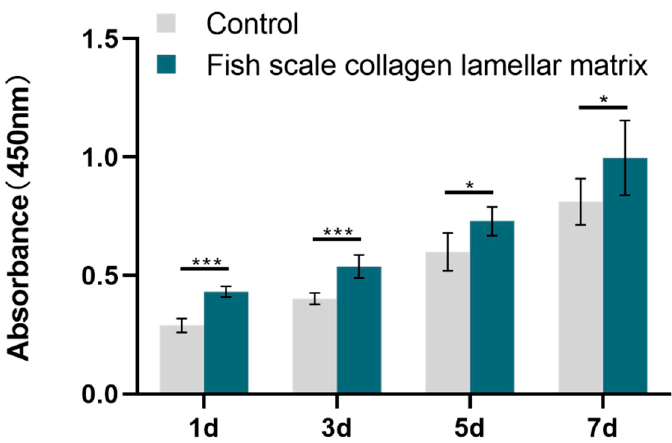
Figure 14. BMSCs proliferation test. * p < 0.05; *** p <